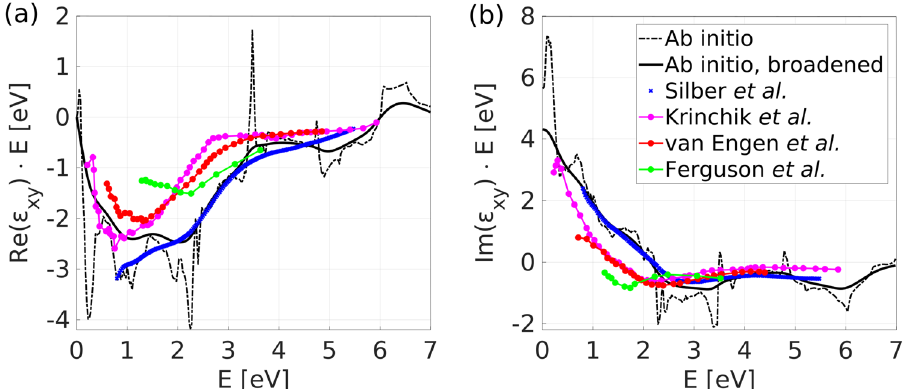
Figure 1. ( a ) Real and ( b ) imaginary part of the linear MO spectra. Black dash-dotted (solid) line is the model without (with) broadening with γ = 0.5 eV, respectively, with the imaginary part obtained by the Kramers– Kronig relations. The experimental results are taken from the literature 1,2,25,32 . Two main peaks at 1.1 eV and 2.0 eV in the real part are well described by the model. The 0 eV limit of the imaginary part corresponds to the AHC = 759.90 ( (cid:31) cm) − 1 in agreement with previous anomalous Hall conductivity, for unbroadened spectra σ xy calculations 45 .